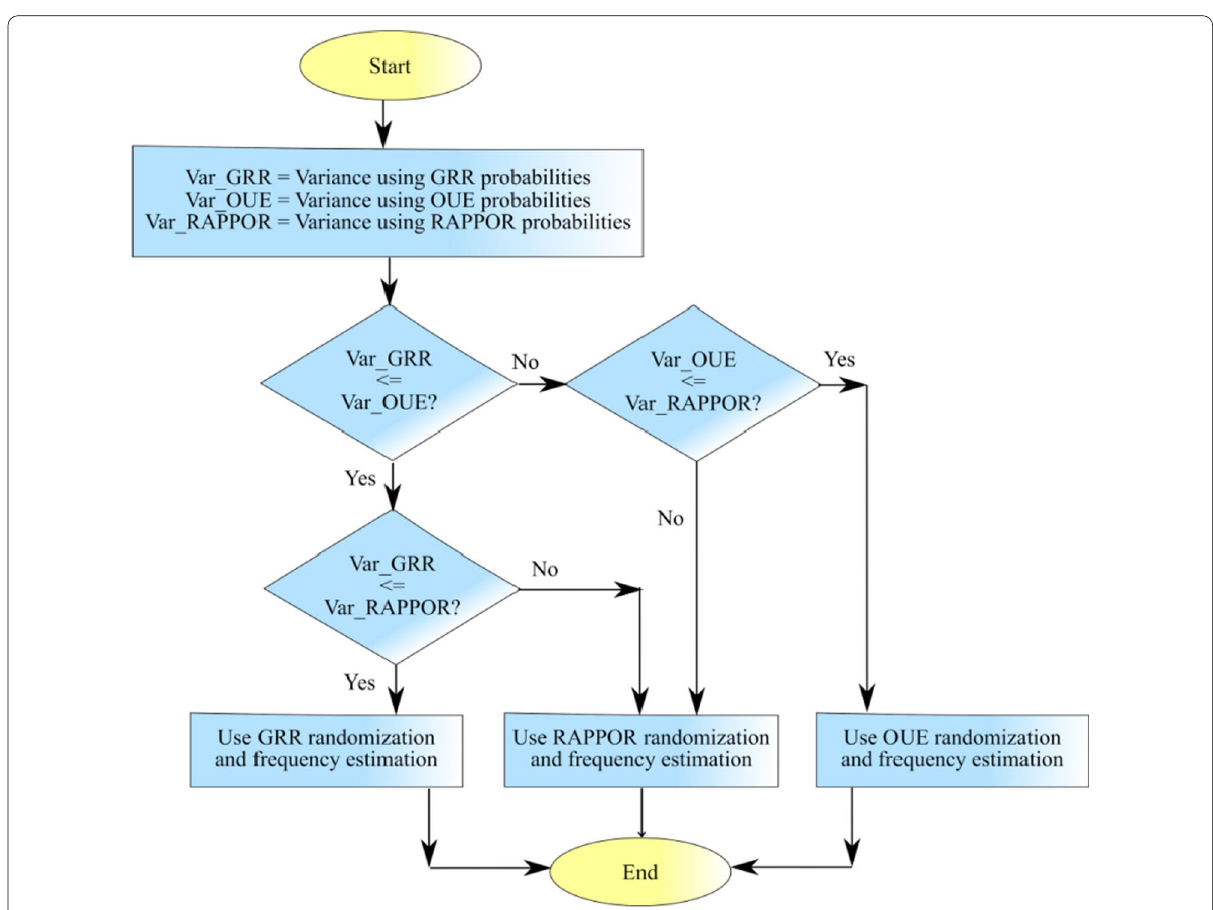
Fig. 4 The flow of logic for an improvised adaptive approach to dynamic randomization using variance as the evaluation